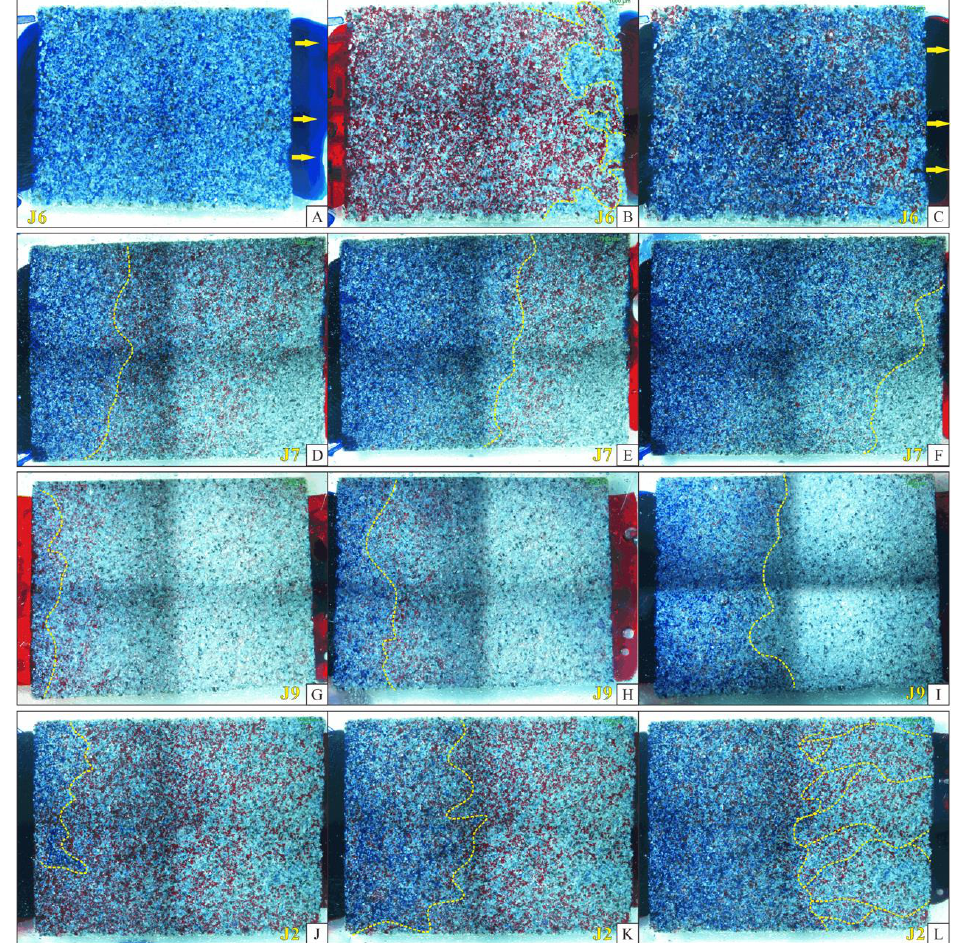
Figure 15. Four types of visualization of the water-flooding effect. (The arrows in ( A , C ) represent the final location of the water-flooded oil seepage channel; the yellow dotted lines in the other figures represent the boundaries at the front of the water-flooded oil at the moment of the photo.). Figure ( A – C ) correspond to sample J6. Figure ( D – F ) correspond to sample J7. Figure ( G – I ) correspond to sample J9. Figure ( J – L ) correspond to sample J2.